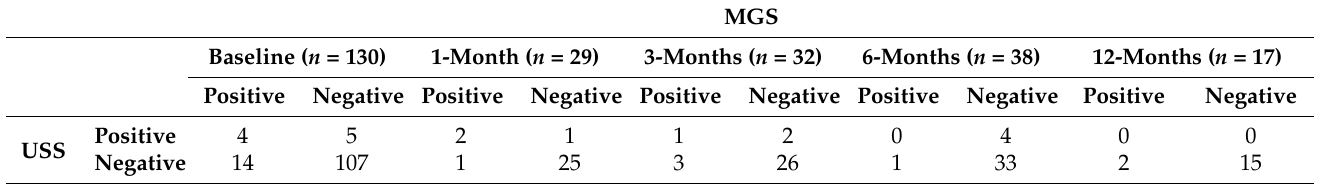
Table A3. Proportion of participants in the study with abnormalities in GU organs on ultrasonography in accordance with their MGS status at all